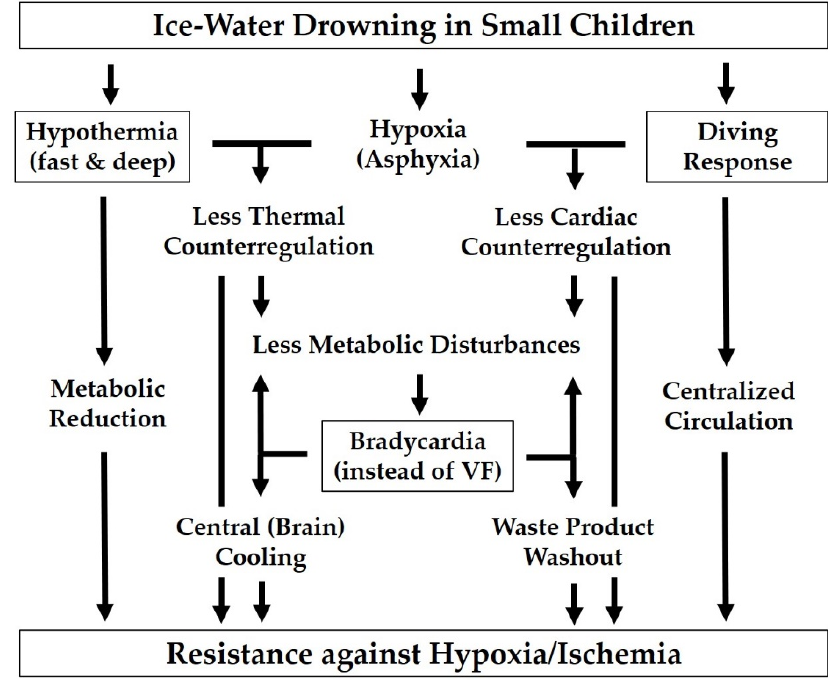
Figure 4. Factors affecting favorable outcome in drowning accidents of young children in ice-cold waters. Both the abrupt overwhelming of the cold defense reaction and the marked diving response attenuate the resulting metabolic disturbances, thereby enhancing the intrinsic resistance of the child’s heart to ventricular fibrillation (VF) or other types of cold-induced cardiac arrest. The sustained slow heart beat provides central brain cooling in addition to continuing washout of waste products from the tissues and thus prevents hypoxia/ischemia from assuming a critical level before a protective degree of hypothermia has been reached (adapted from [74]).